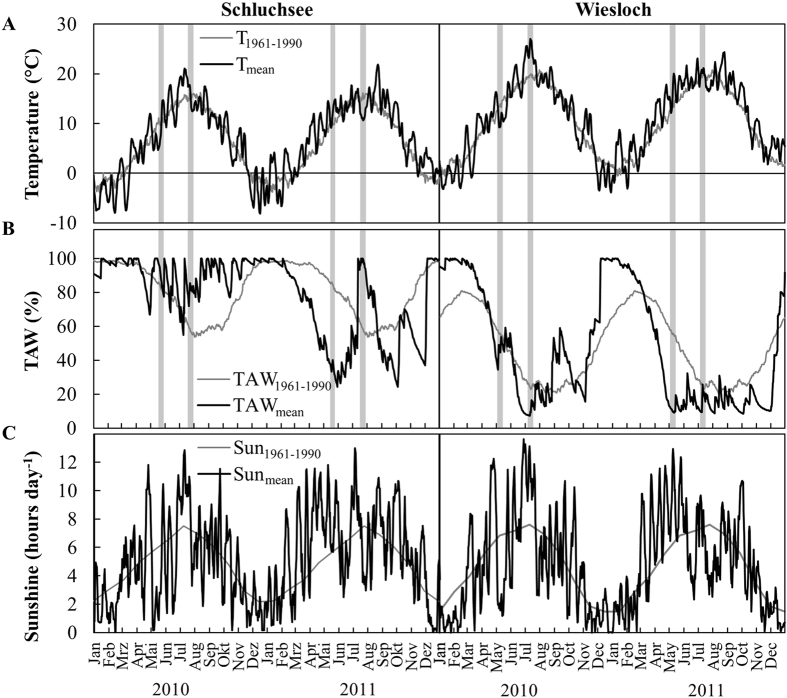
Annual climate at the field sites in 2010 and 2011 and for a 30-year reference period (1961–1990).(A) 5-day running average of mean daily temperature (Tmean) and mean daily temperature for the reference period (T1961–1990), (B) mean daily total available soil water for 2010 and 2011 (TAWmean) and the reference period (T1961–1990), and (C) sunshine duration in hours per day in 2010 and 2011 (Sunmean) and the reference period (Sun1961–1990) at the two field sites Schluchsee and Wiesloch. Gray bars indicate time of the 8 measurement campaigns.